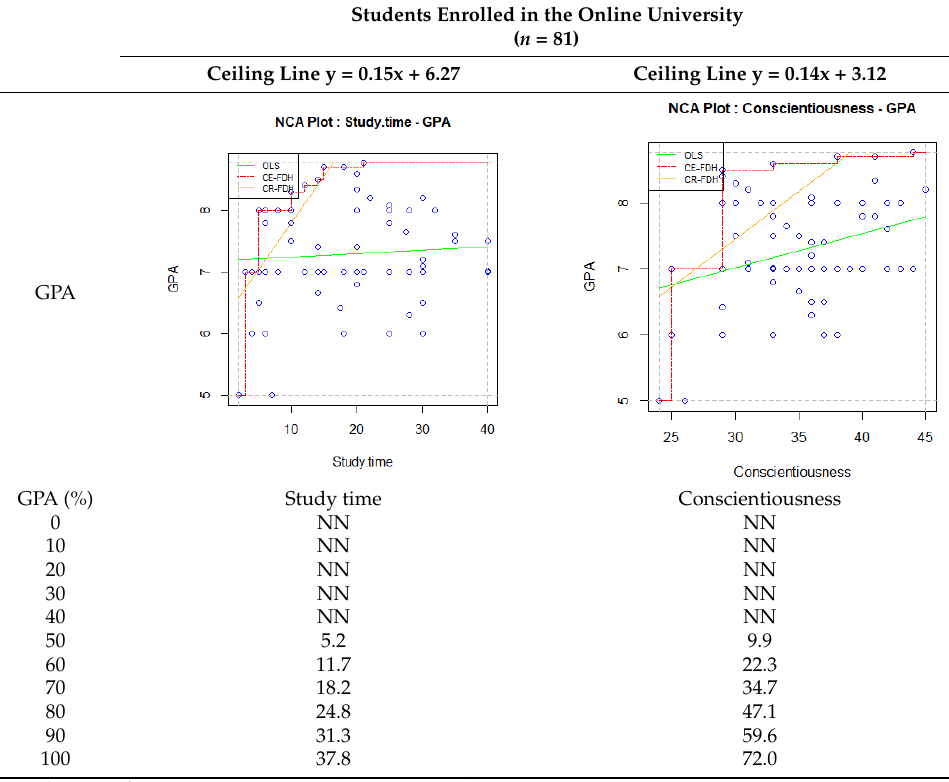
Table 2. Necessary condition effect sizes and significance tests for admission grade, study time, and conscientiousness as predictors of college grade point average (GPA).